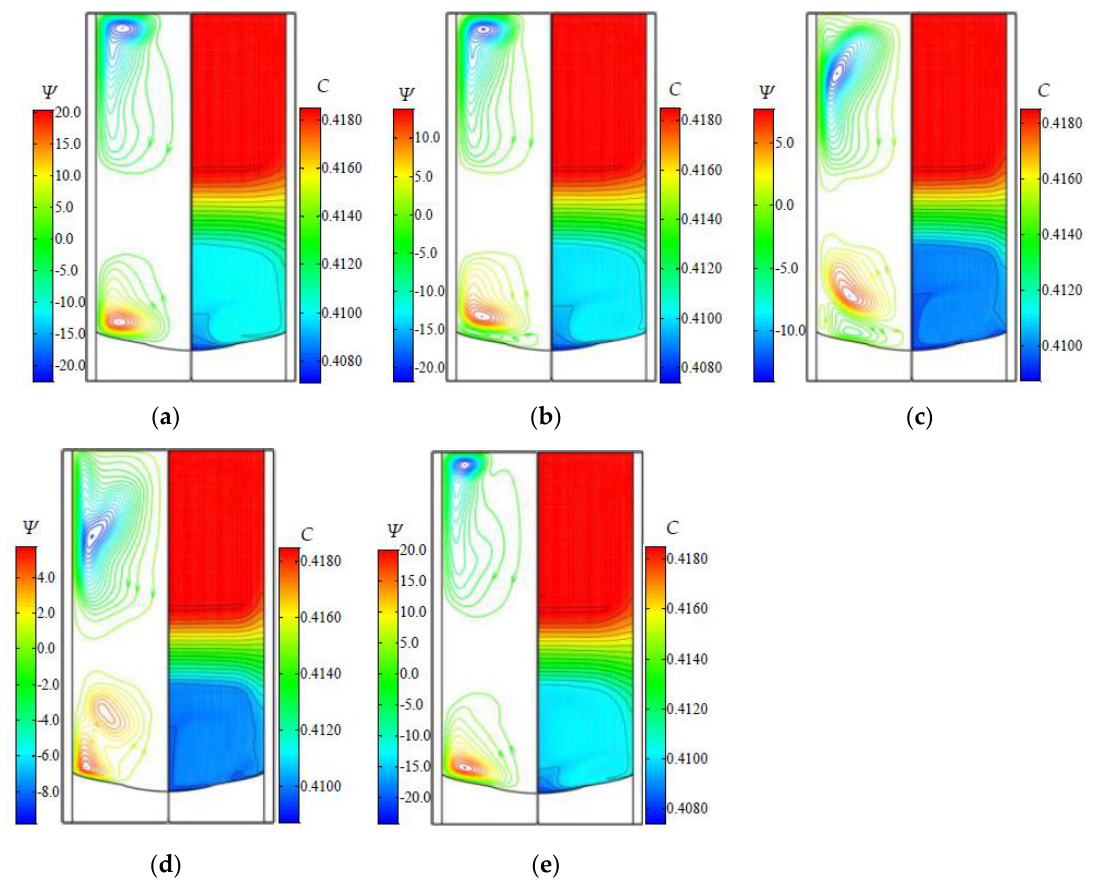
Figure 6. Flow ( Ψ (mm 3 /s)) and concentration ( C ) fields in the solution during the first half of the 5th period of ACRT Sequence 3. ( a – e ) Results at 5A–5E, respectively.